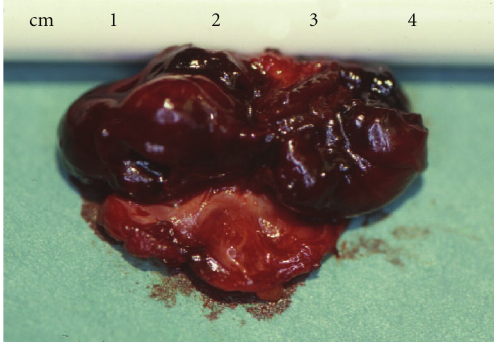
Figure 3: Macroscopic view of the removed aneurysm cut in half longitudinally.